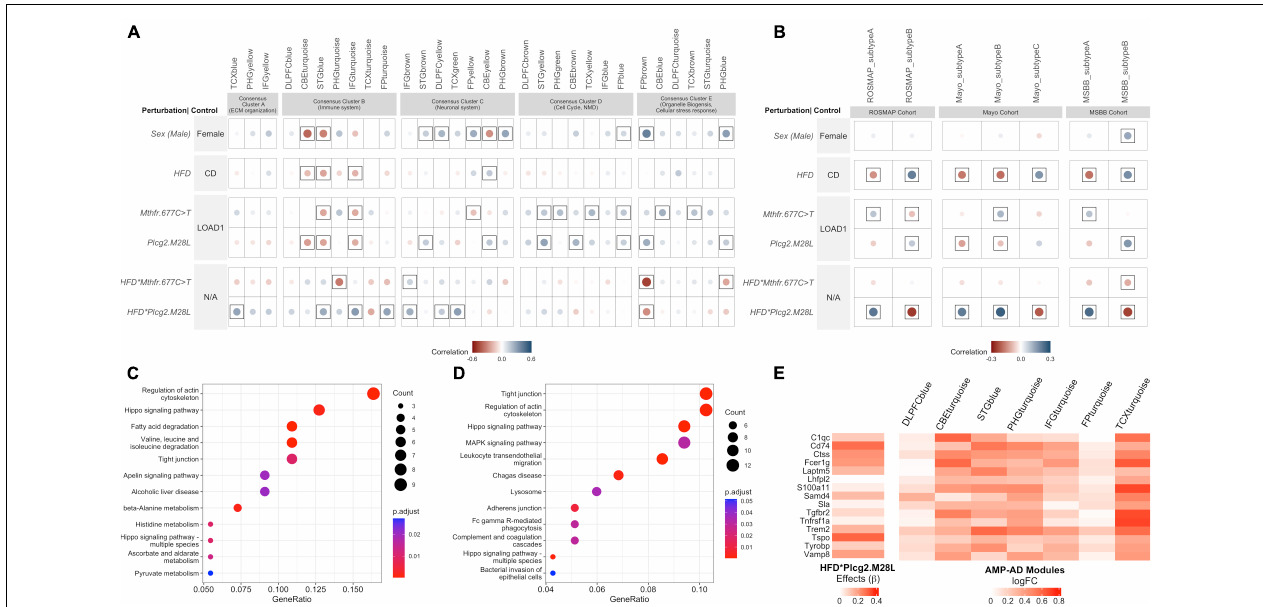
FIGURE 5 | Interaction between HFD and Plcg2 M 28 L in mice exhibits transcriptional changes in immune function similar to human LOAD. (A) Correlation between the effect of each mouse perturbation and 30 human co-expression modules. Each column represents one of the 30 human co-expression modules identified in seven different brain regions: the dorsolateral prefrontal cortex (DLPFC), superior temporal gyrus (STG), frontal pole (FP), parahippocampal gyrus (PHG), temporal cortex (TCX), inferior frontal gyrus (IFG), and cerebellum (CBE). These modules are grouped into five consensus clusters with similar gene content across the multiple studies and brain regions. Note that HFD* Plcg2.M28L and HFD* Mthfr.C677T results denote interaction effects separated from the individual effects of diet and variants. Controls for corresponding rows were therefore labeled N/A as the control is not strictly defined. Circles within a square correspond to significant ( p < 0.05) positive (blue) and negative (red) Pearson’s correlation coefficients. The color intensity and size of the circles are proportional to Pearson’s correlation coefficient. (B) Correlation between the effect of each mouse perturbation and molecular subtypes of LOAD. The columns represent the two molecular subtypes associated with LOAD in the Religious Orders Study and the Memory and Aging Project (ROSMAP) cohort, three molecular subtypes associated with LOAD in the Mayo cohort, and two molecular subtypes associated with LOAD in the Mount Sinai Brain Bank (MSBB) cohort (Milind et al., 2020). The effects of interaction between HFD and Plcg2 M 28 L in mice significantly correlate with the inflammatory subtypes of LOAD (Subtypes A) in each of the cohorts. Circles within a square correspond to significant ( p < 0.05) positive (blue) and negative (red) Pearson’s correlation coefficients. (C) Kyoto Encyclopedia of Genes and Genomes (KEGG) Pathway enrichment analysis (FDR adjusted p < 0.05) of genes exhibiting directional coherence between the effects of interaction between HFD and Plcg2 M 28 L in mice and ECM organization related AMP-AD modules in Consensus Cluster A. (D) KEGG Pathway enrichment analysis (FDR adjusted p < 0.05) of genes exhibiting directional coherence between the effects of interaction between HFD and Plcg2 M 28 L in mice and immune-related AMP-AD modules in Consensus Cluster B. (E) Identification of genes exhibiting directional coherence for the interaction between HFD and Plcg2 M 28 L in mice and change in the expression of immune-associated AMP-AD modules in Consensus Cluster B, including microglia-related genes